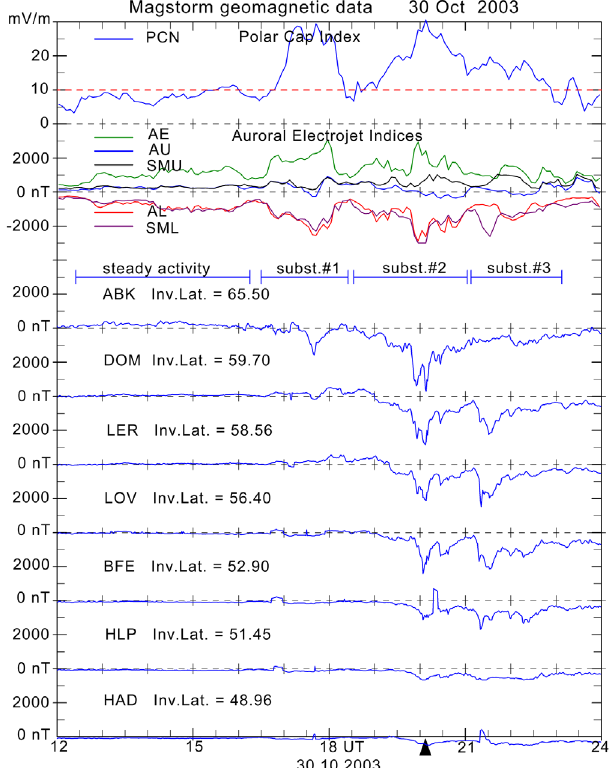
Fig. 4. PCN index displayed in top fi eld. Auroral electrojet indices AU, AL, and AE and SuperMag SMU and SML indices in second and third fi eld. Next lower fi elds display recordings of the variations in the horizontal geomagnetic component counted positive when northward for a series of observatories ordered from top at decreasing latitudes. The black triangle marks HV power line